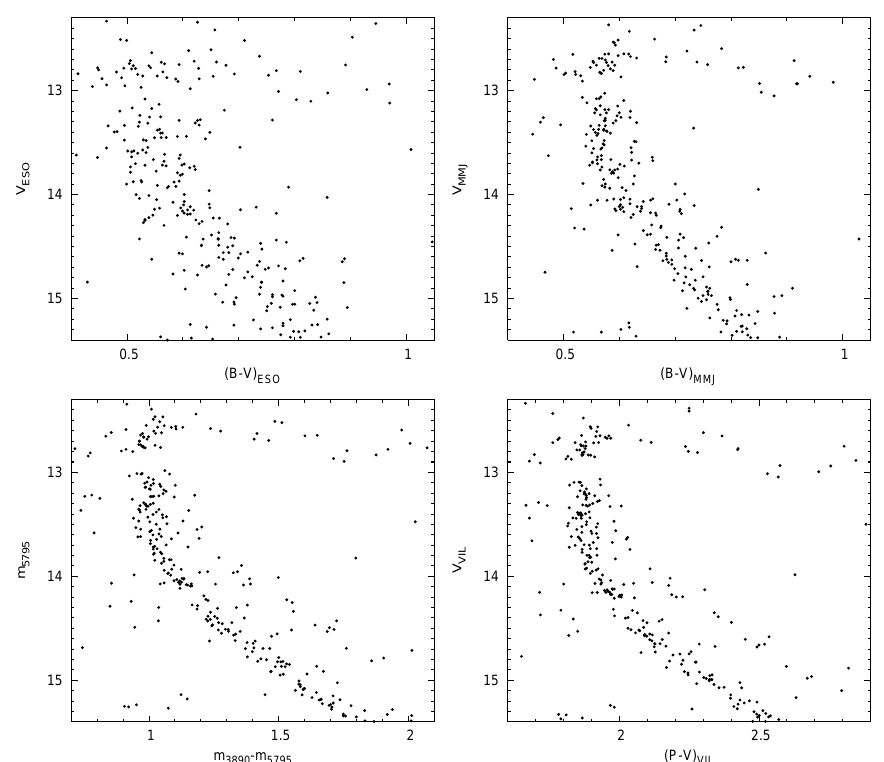
Fig. 4. The CMD diagram of M 67 near the MS turnoff for stars in common to Vilnius, BATC, ESO and MMJ datasets. The sharpness of gaps in the MS at V ≈ 13.0 and 14.2 mag and the sequences of subgiants and binaries can be used as the indicators of photometric